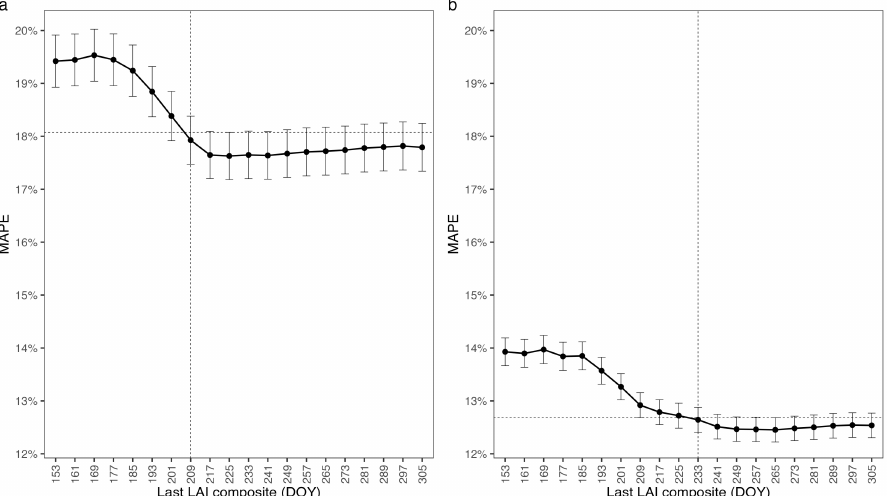
Figure 4. The MAPE of the estimates of ( a ) corn and ( b ) soybean yield in 2010–2016 based on different LAI time series. The first date of LAI time series was set to be the day of year (DOY) of 89. The last date of the time series was set differently from DOY 153–305. The point and error bar indicates the MAPE and the standard error, respectively. The vertical dashed line indicates the earliest DOY when the MAPE was within one standard error of the least one indicated by the horizontal dashed line.